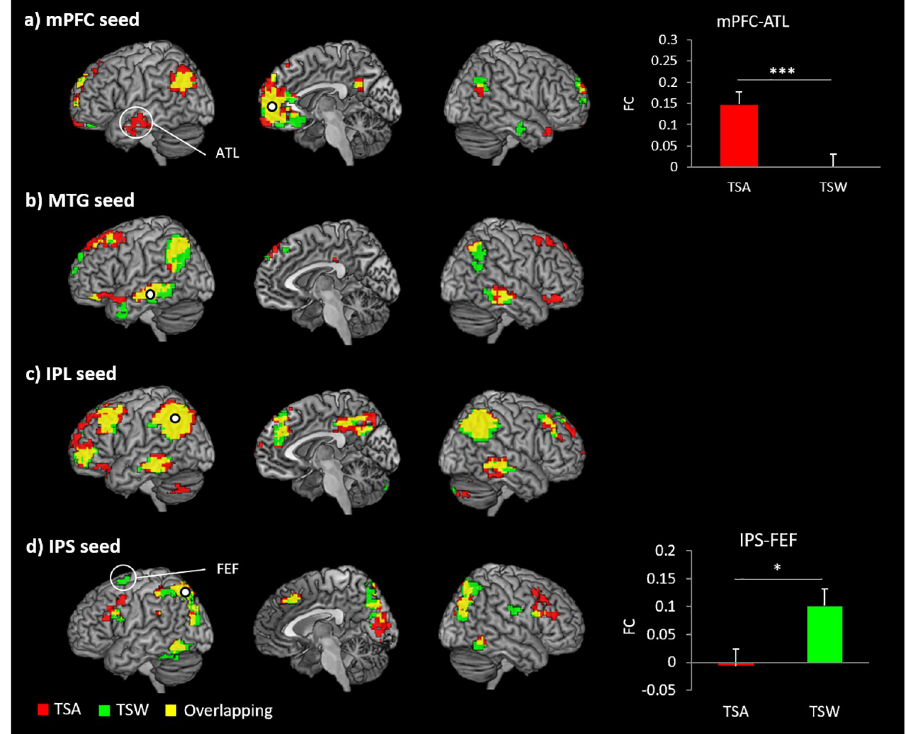
Fig 5. Functional connectivity results. Red indicates TSA condition, green indicates TSW condition, and yellow indicates overlapping. ��� p < 0.001, � p < 0.05.